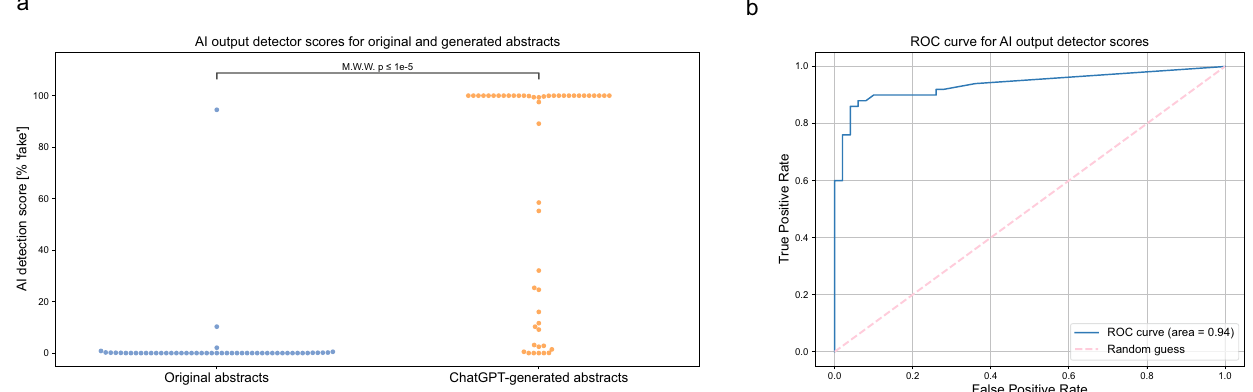
Fig. 2 Many generated abstracts can be detected using an AI output detector. a AI detection scores as [% ‘ fake ’ ] per GPT-2 Output Detector for original abstracts and generated abstracts. Higher score indicates more likely to be generated by AI. b The AI output detector ROC curve for discriminating between original and generated abstracts, with AUROC of